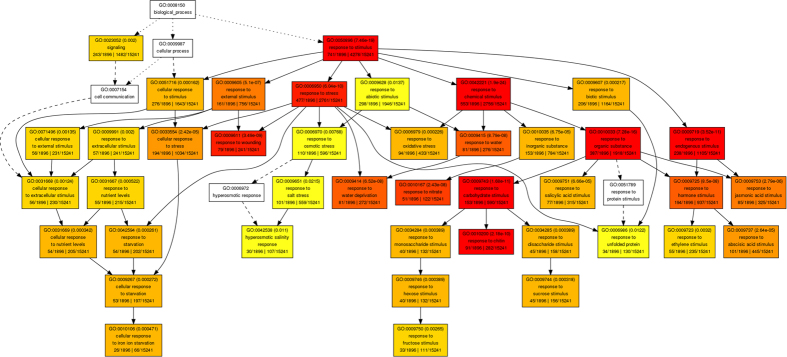
Agri GO analysis of DEGs in roots.Singular enrichment analysis was performed in AgriGO to identify enriched gene ontologies associated with high tillering lines. Each box shows the GO term number, the p-value in parenthesis, and GO term. The pair of numerals in the left represents number of genes in input list associated with that GO term and number of genes in input list. The pair of numerals in the right represents number of genes associated with a particular GO term in the Gossypium database and total number of Gossypium genes with GO annotations in the Gossypium database. Box colors indicate levels of statistical significance: yellow = 0.05; orange = e−5; and red = e−9.